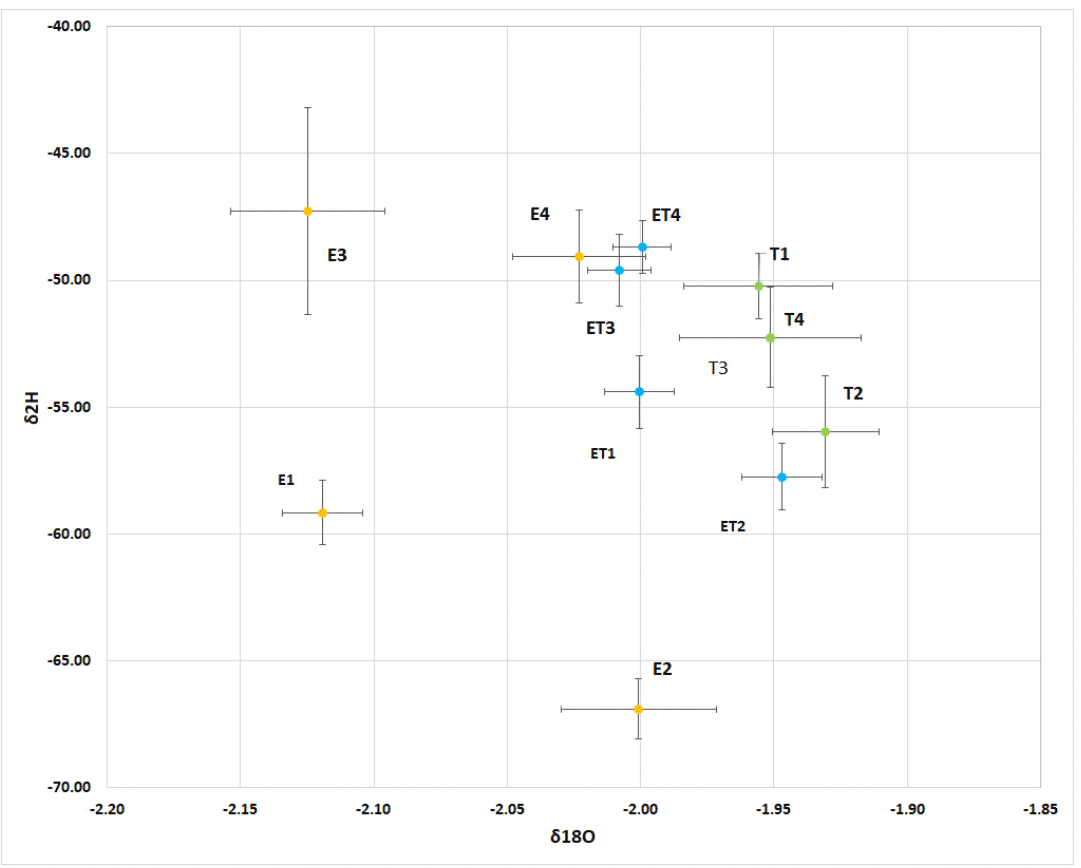
Figure 4. Field isotope observations. Each sample and type are labeled numerically for each cycle.